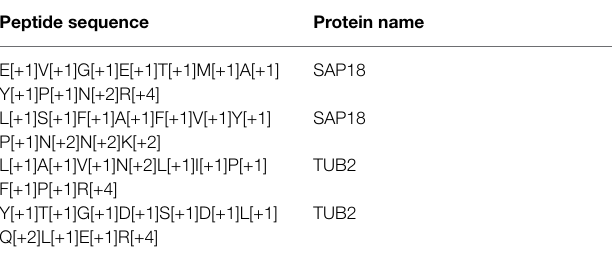
TABLE 3 | Output from the R script that converts peptide sequence to heavy peptide sequence recognizable by Skyline. Peptide